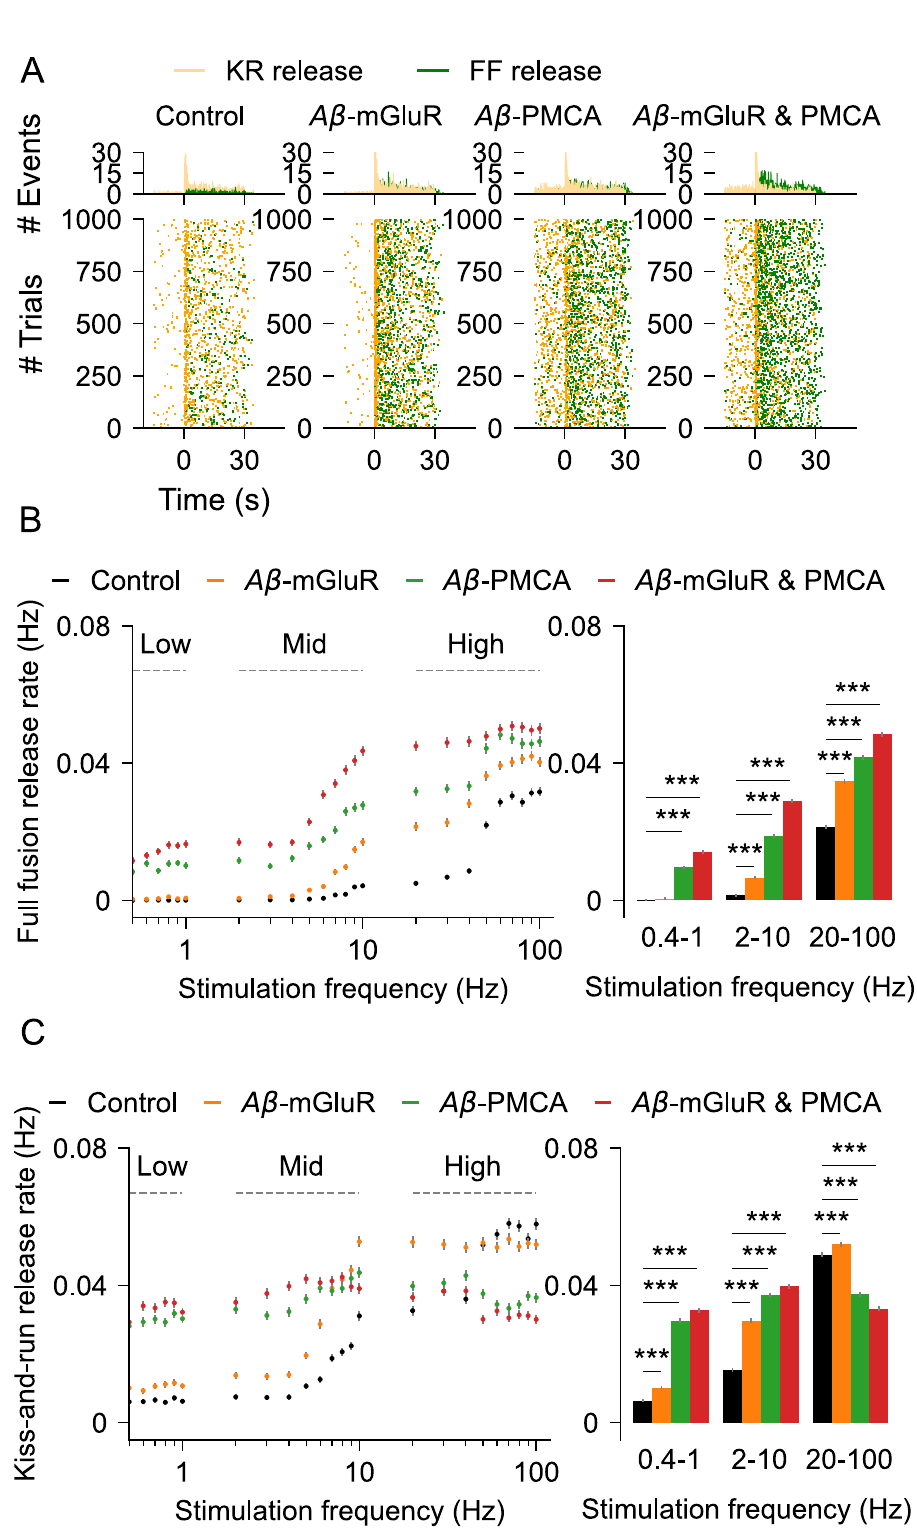
Fig 6. Quantification of gliotransmission in astrocytic compartments stimulated with glutamate. (A) Raster plots of kiss-and-run and full-fusion releases in control astrocyte and in the presence of A β conditions. Top : temporal histograms. (B) Rate of full fusions for different glutamate stimulation rates. Right : release rates for the three stimulus groups (C) Rate of kiss-and-run exocytosis. Right: release rates pooled into three simulation groups. Error bars indicate the standard error of the mean computed from 6 independent